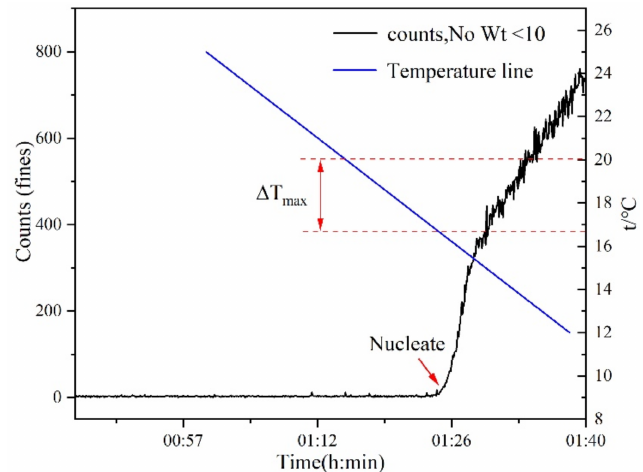
Figure 2. Schematic diagram of measuring the metastable zone by the Focused Beam Reflectance Meter (FBRM) (taking the saturation temperature of 293.15 K, stirring rate of 300 rpm, ethanol mass fraction of 0.6, and cooling rate of 20 K/h as an